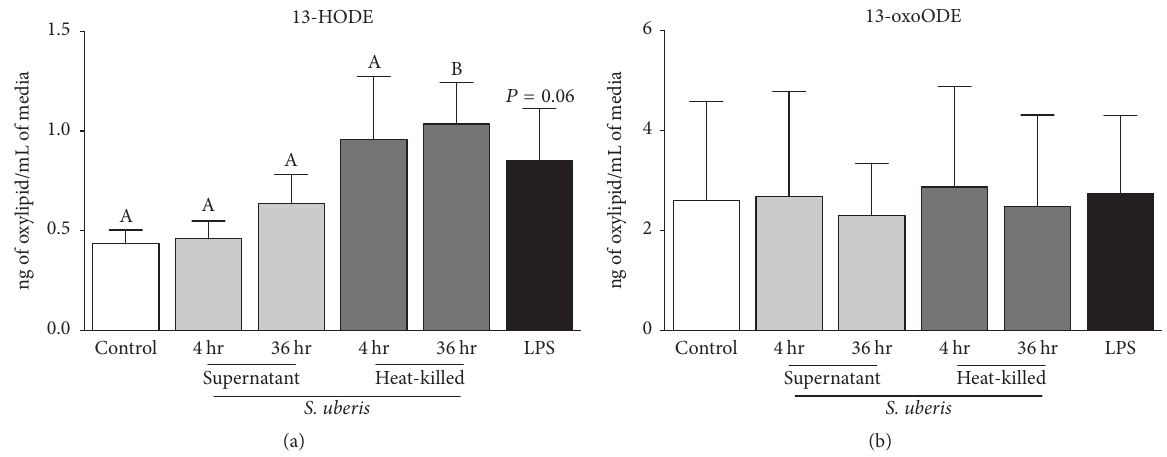
Figure 4: Monocyte oxylipid biosynthesis following 4 hr LPS (black bars) or S. uberis exposure. Media controls are displayed as open bars. Light grey bars represent S. uberis supernatant exposure for 4hr and 36 hr. Dark grey bars represent heat-killed S. uberis exposure for 4 hr and 36 hr. Mean oxylipid biosynthesis is expressed as ng of oxylipid/mL of media. Letters that differ between control time points, 4hr and 36hr separately, denote significant differences between control and among treatments as measured by an ordinary one-way ANOVA with Tukey’s post hoc correction. For example, 4hr exposure to S. uberis supernatant or heat-killed S. uberis did not modify 13-HODE biosynthesis, whereas 36 hr exposure to heat-killed S. uberis did increase 13-HODE biosynthesis. No letters are displayed in (b) as no differences were detected in any time points. Significance for differences declared at 𝑃 ≤ 0.05 ( 𝑛 = 4